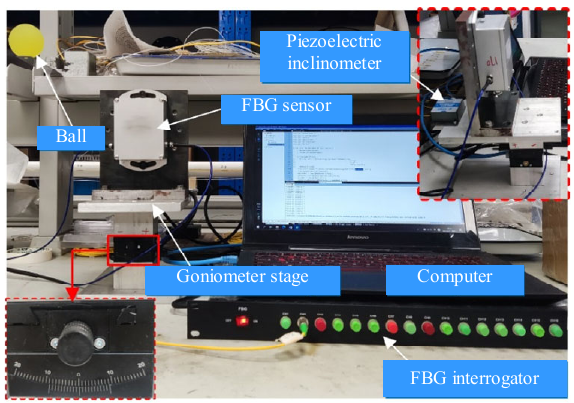
Fig. 9 Performance test platform of the